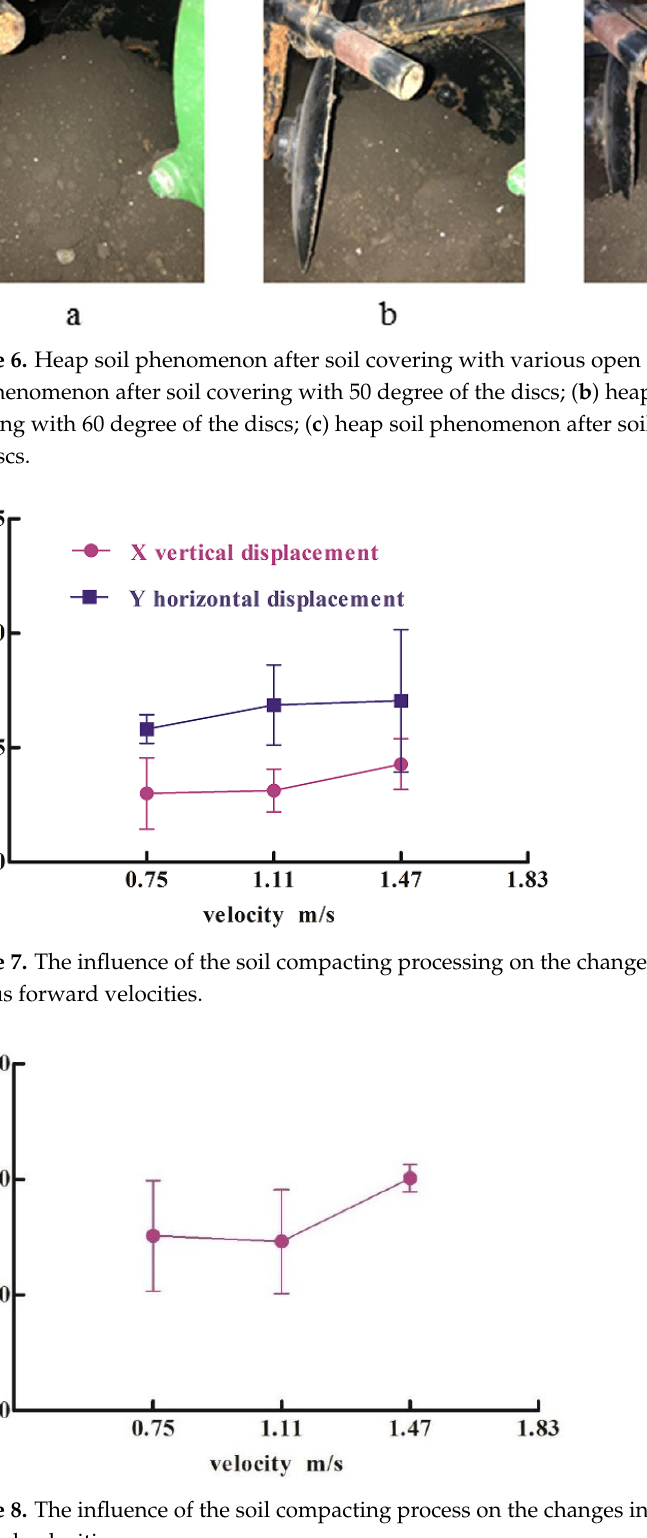
Figure 8. The influence of the soil compacting process on the changes in sowing depth with various forward velocities.